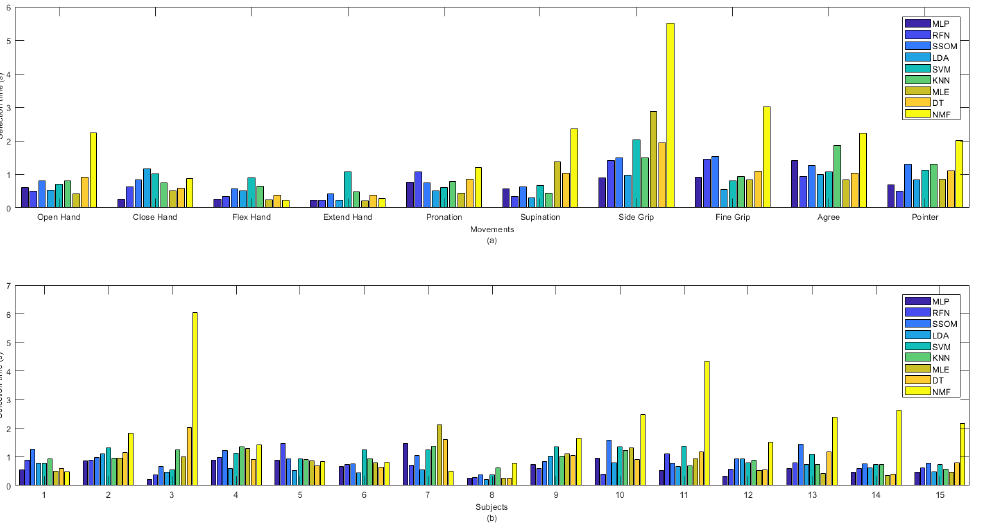
Figure 6. Selection time in second between classifiers per ( a ) movements and ( b ) subjects.